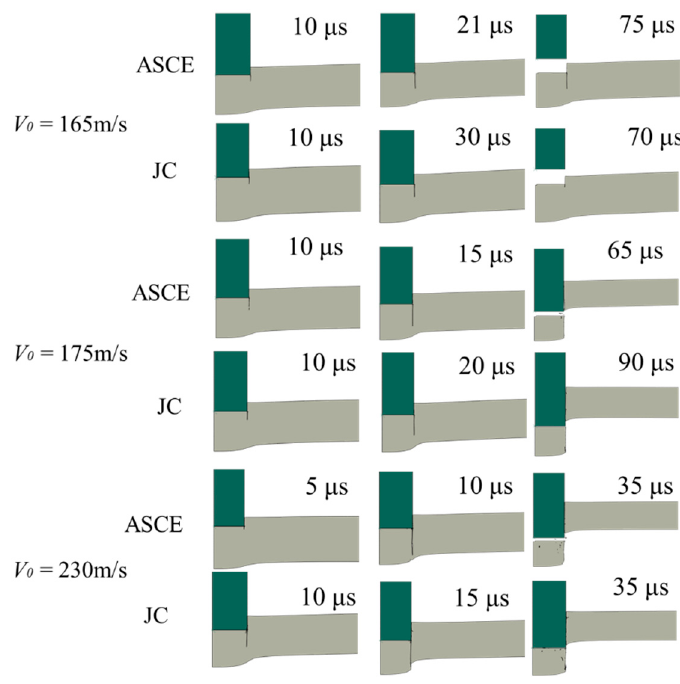
Figure 11. Fracture behavior of targets with an element size of 20 μ m.